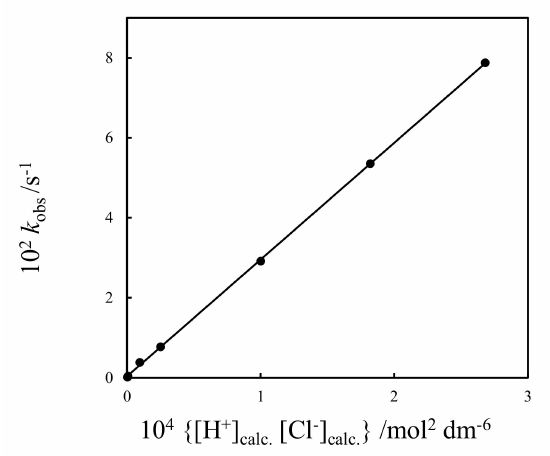
Figure 1. The dependence of the k obs for the reaction of formaldehyde with nitrosobenzene in an acetonitrile-water (92.6% acetonitrile) solution on the effective concentration of the chloride anion. The points are an average of at least 3–4 runs at 25 ◦ C, 0.200 M HCHO, and 0.0005–0.07 M HCl, k obs = k [HCHO] tot [H + ]. The concentrations of the chloride anion were calculated from the concentrations of the HCl added, taking the value of 2.0 × 10 2 M − 1 for the association constant of HCl in a 92.6% acetonitrile-water solution at 25 ◦ C (see Table